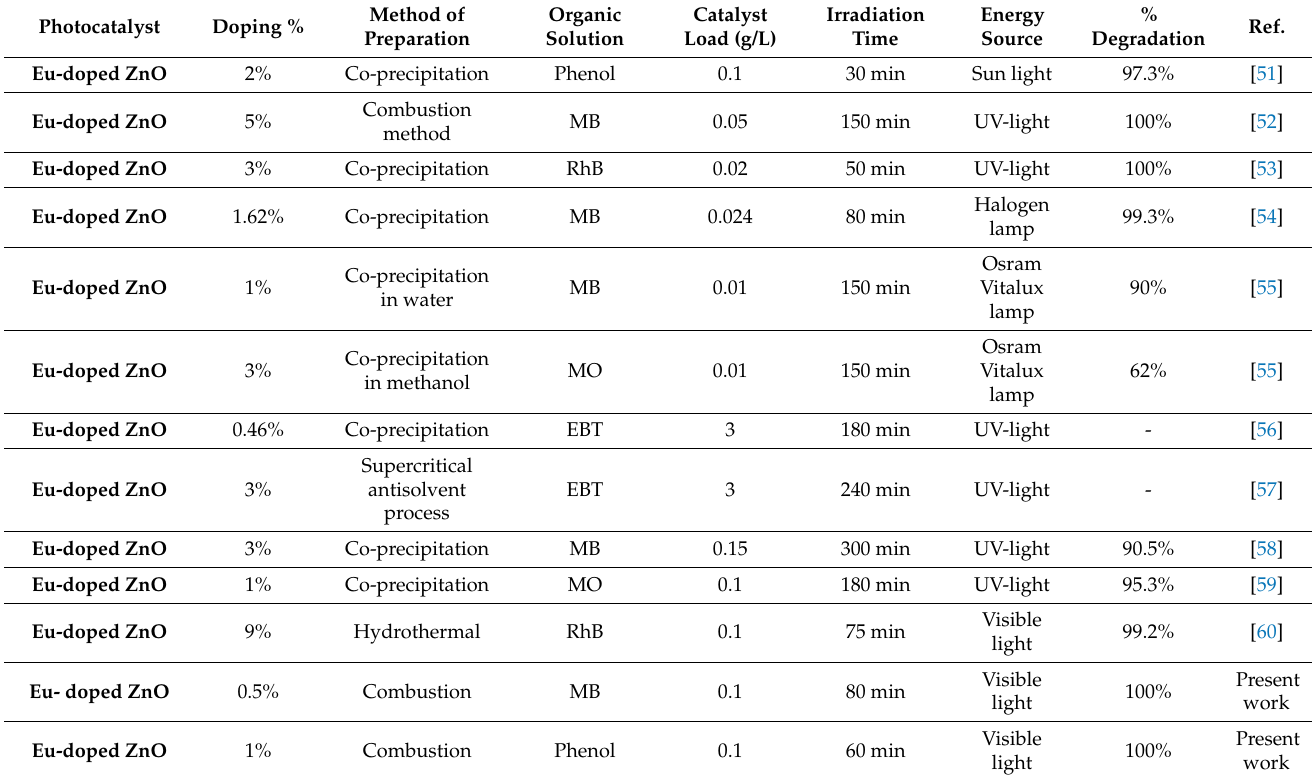
Table 4. Reaction rate constants of MB and Ph degradation in all prepared